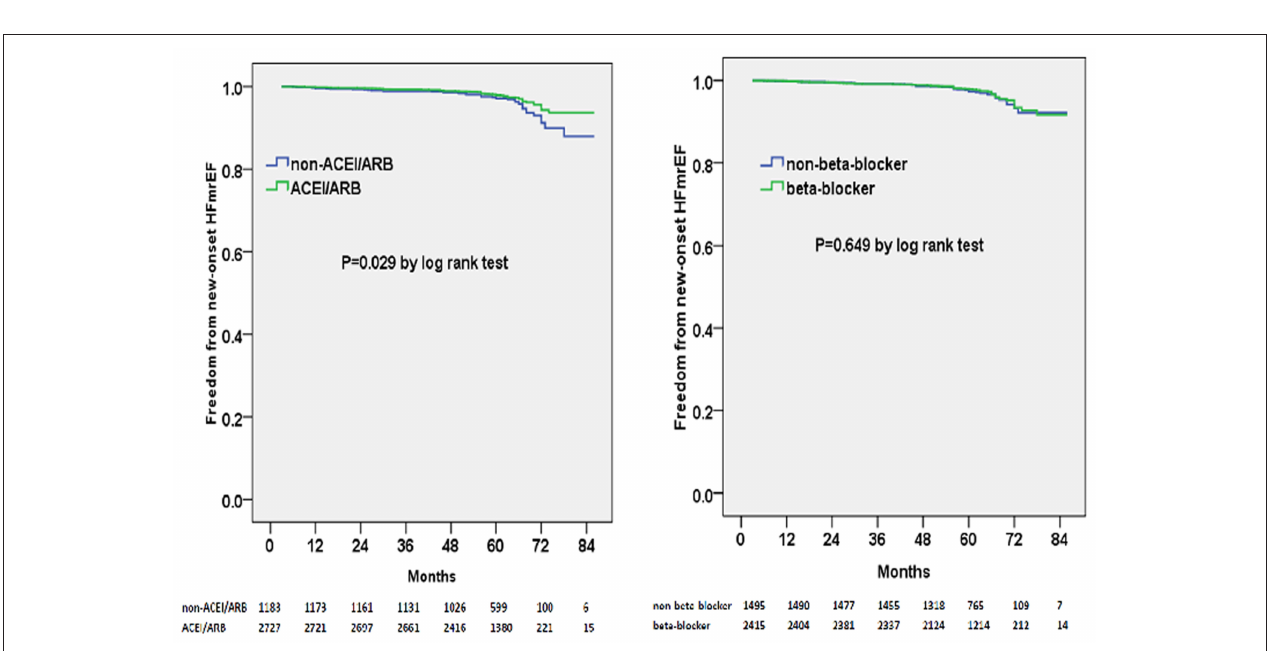
FIGURE 4 | Kaplan–Meier curves of freedom from new-onset HFmrEF for different medical treatments. The numbers at the bottom of the figure are “number at risk”.